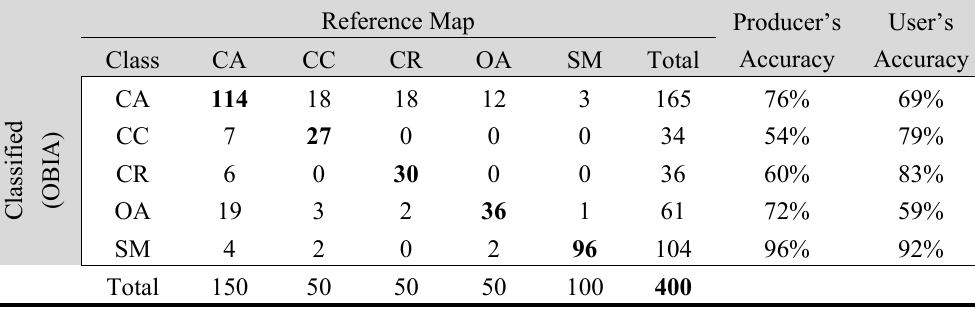
Table 5. Error matrix of object-based classified map versus reference